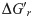
Computed pathways for L-Methionine biosynthesis: r1, r2, r3, r4 and r5.Round rectangles represent compound nodes, rectangles represent reaction edges, and the data in parentheses denote the value ΔG′r of reaction and compound similarity respectively. “*” means that the Gibbs free energy of the corresponding reaction is not available.